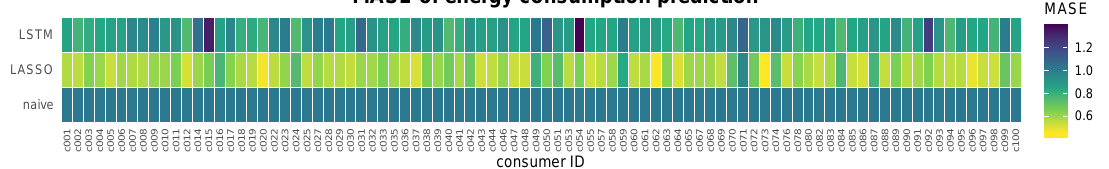
Figure 6. Heat map of MASE scores for the prediction of consumption values per consumer dataset. BLEMevaluateEnergyPreds (github.com/QuantLet/BLEM/tree/master/BLEMevaluateEnergyP